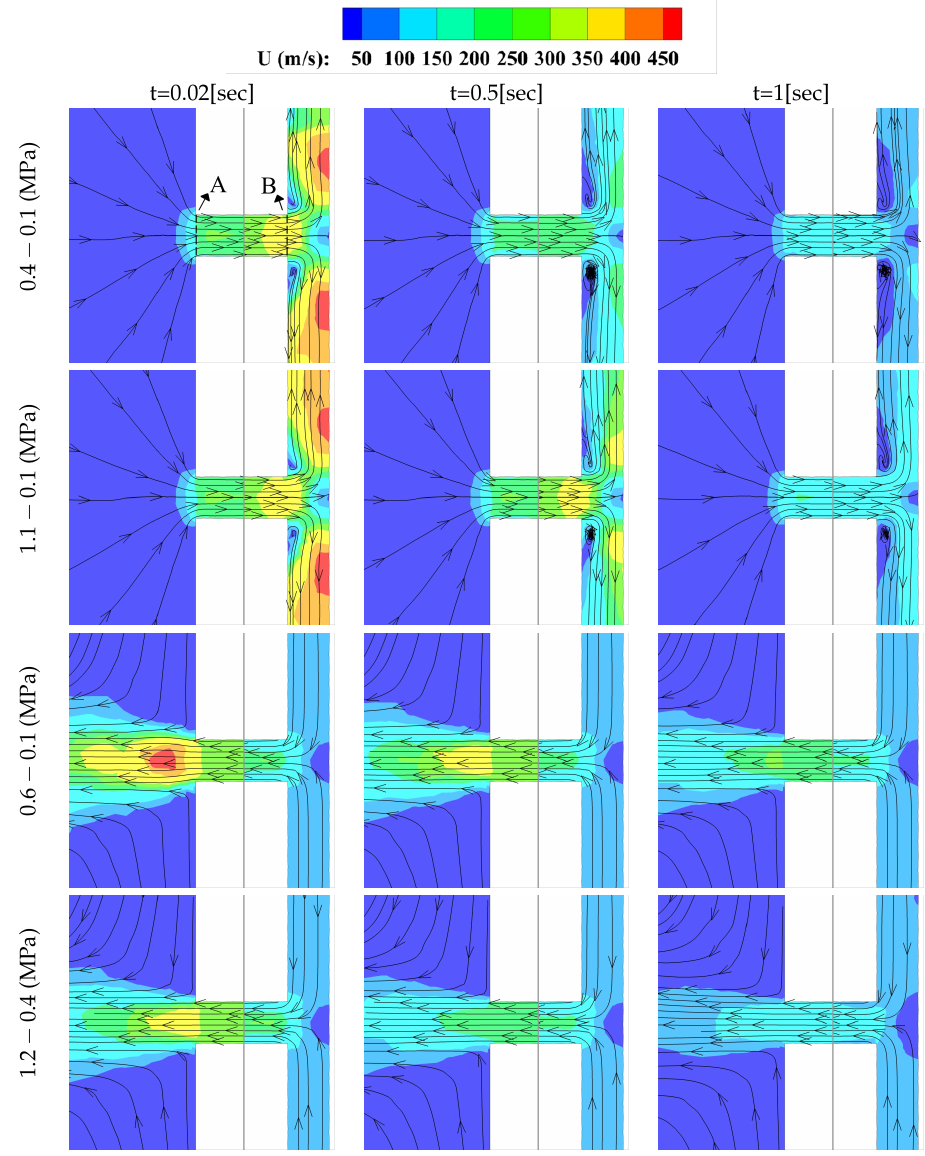
Figure 11. Velocity contours of all CFD cases studied and at three instants, 0.02, 0.5, and 1 s. The first and second rows represent the fluid evolution when the fluid goes from the L-to-S reservoir, and the respective upstream/downstream initial pressures are 0.4 MPa–0.1 MPa and 1.1 MPa–0.1 MPa. The third and fourth rows characterize the two cases when the flow goes from S-to-L reservoir, being the upstream/downstream initial pressures of 0.6 MPa–0.1 MPa and 1.2 MPa–0.4 MPa,